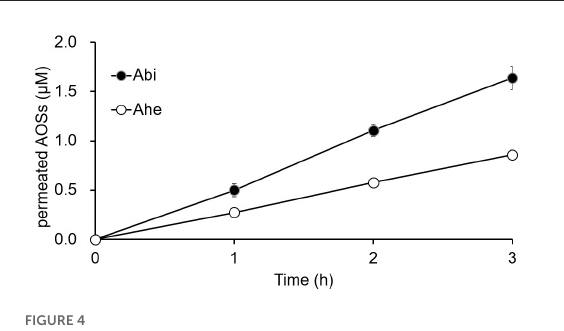
FIGURE4 The cumulative amounts of Abi and Ahe that permeated the Caco-2 cell monolayers. Abi and Ahe were added to the apical chamber of the Transwell insert wherein the Caco-2 cell monolayers were cultured. Subsequently, the basolateral solution was taken, and the amount of permeated Abi or Ahe was quantified using LC-MS. Each value represents the mean ± SE ( n =